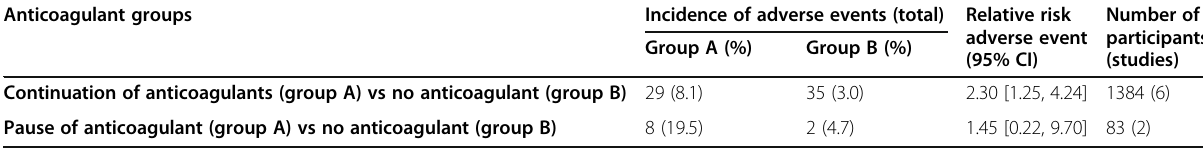
Table 3 Summary of the interventions Anticoagulant groups Incidence of adverse events (total) Relative risk